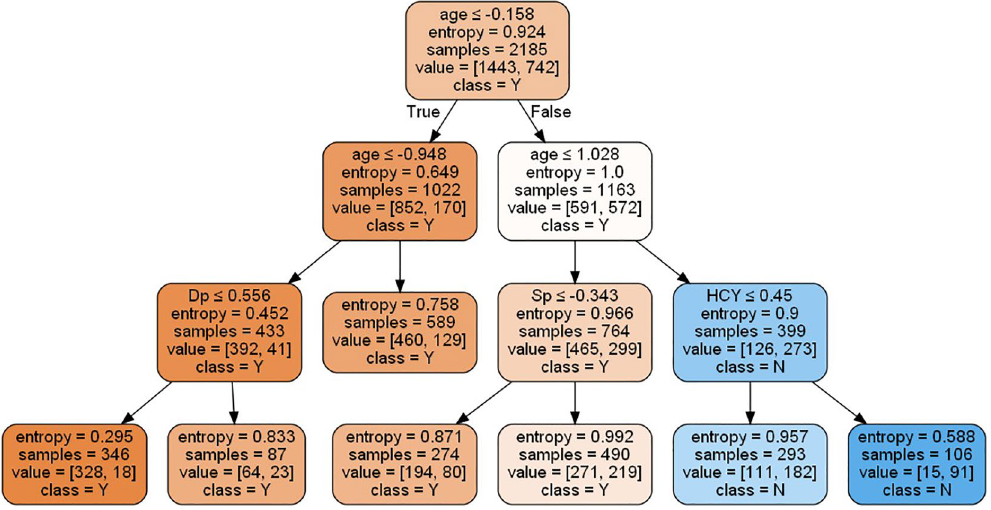
Figure 2. Decision tree. DP, diastolic blood pressure; SP, systolic blood pressure; HCY, homocysteine; Y = Yes; N = No.